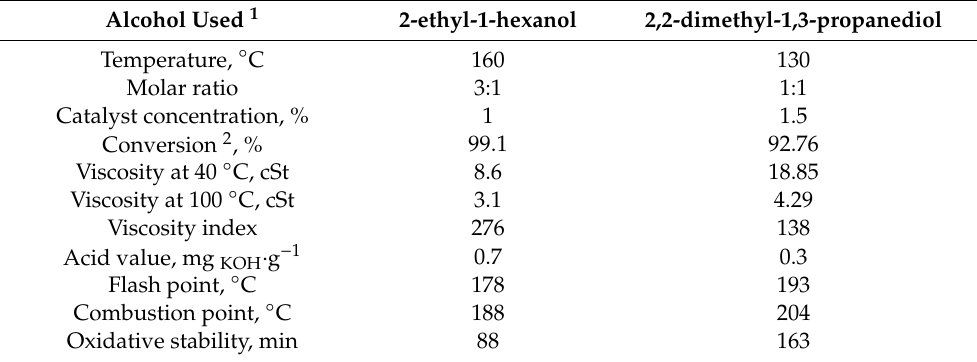
Chemical conditions and properties of the biolubricants obtained under optimum reaction